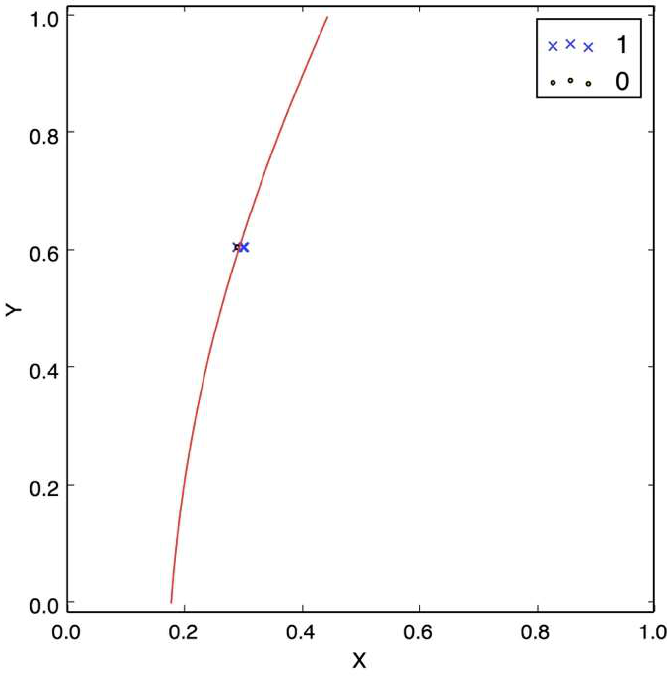
Figure 7. The decision surface (solid line) obtained from the attack when the attractor is not chaotic.